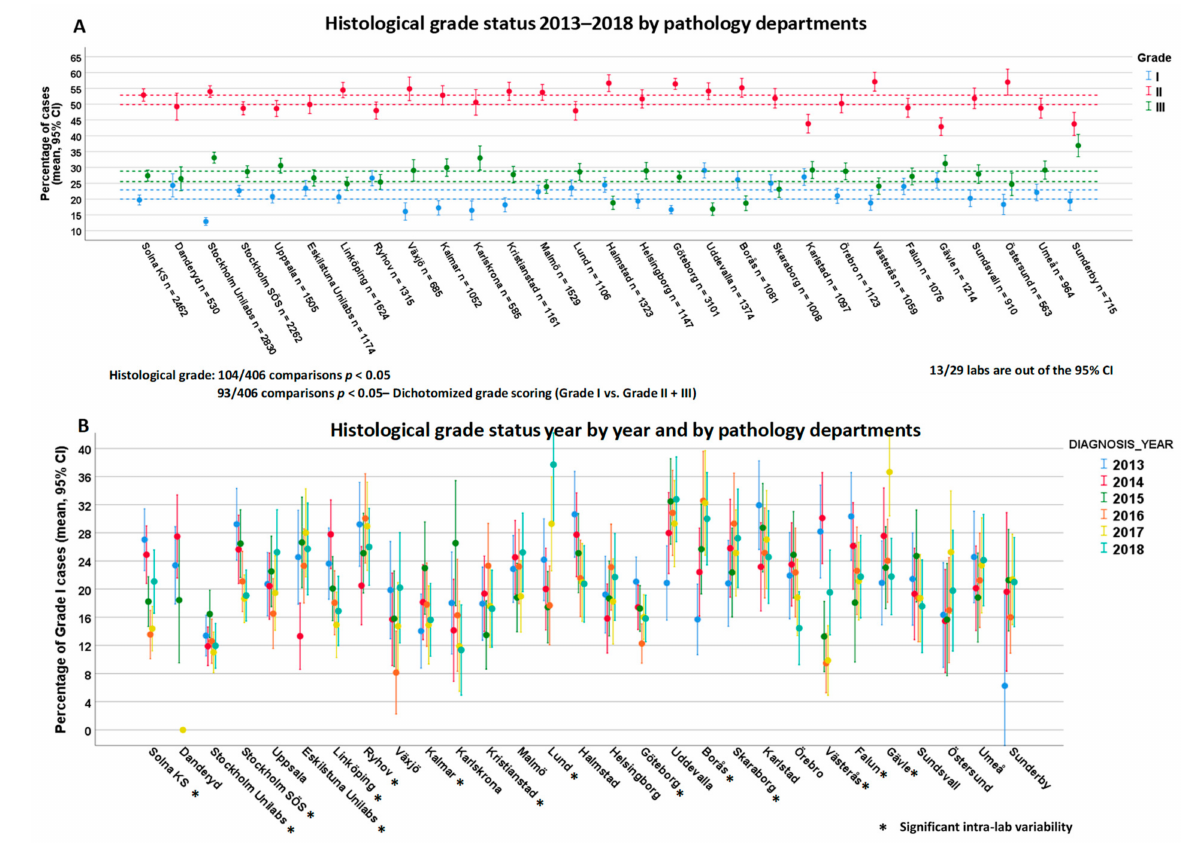
Figure 5. Inter- ( A ) and intra-laboratory variability ( B ) for histological grade status among 29 pathology